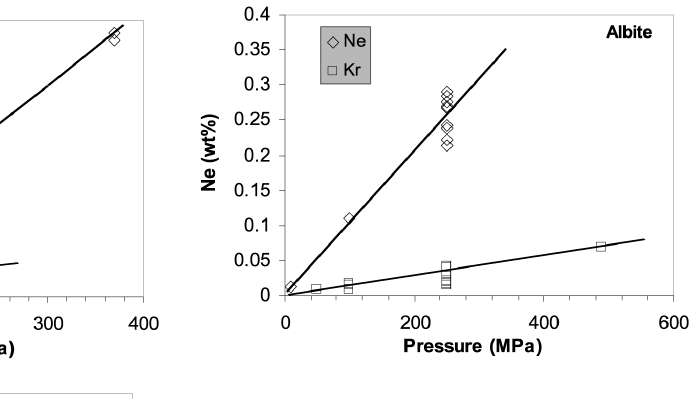
Fig. 3. Neon and krypton solubilities in albite glass at 1000 and 750°C, respectively. Data are taken from Roselieb et al . (1992).